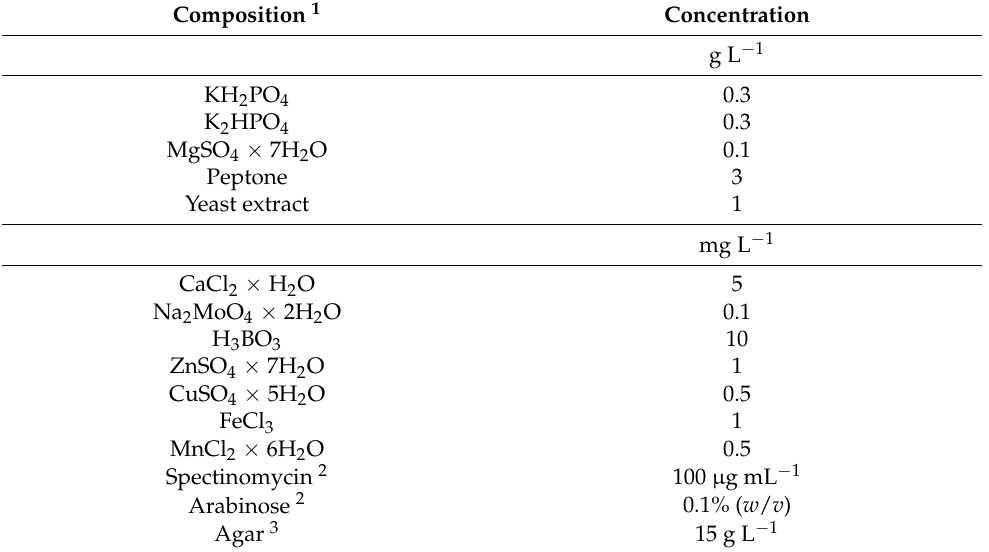
Table 1. Modified peptone-salts-yeast extract (PSY) medium composition used for B. diazoefficiens 110 spc 4